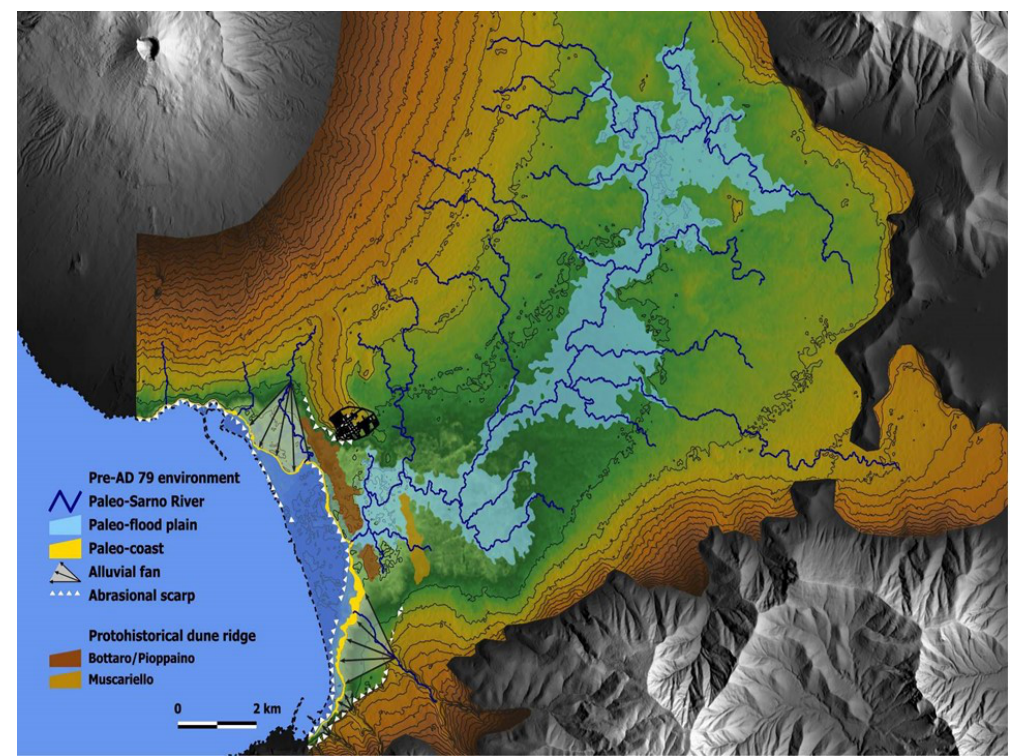
Figure 6. Pre-79 AD environmental reconstruction of the Sarno River plain, Campania, Italy according to